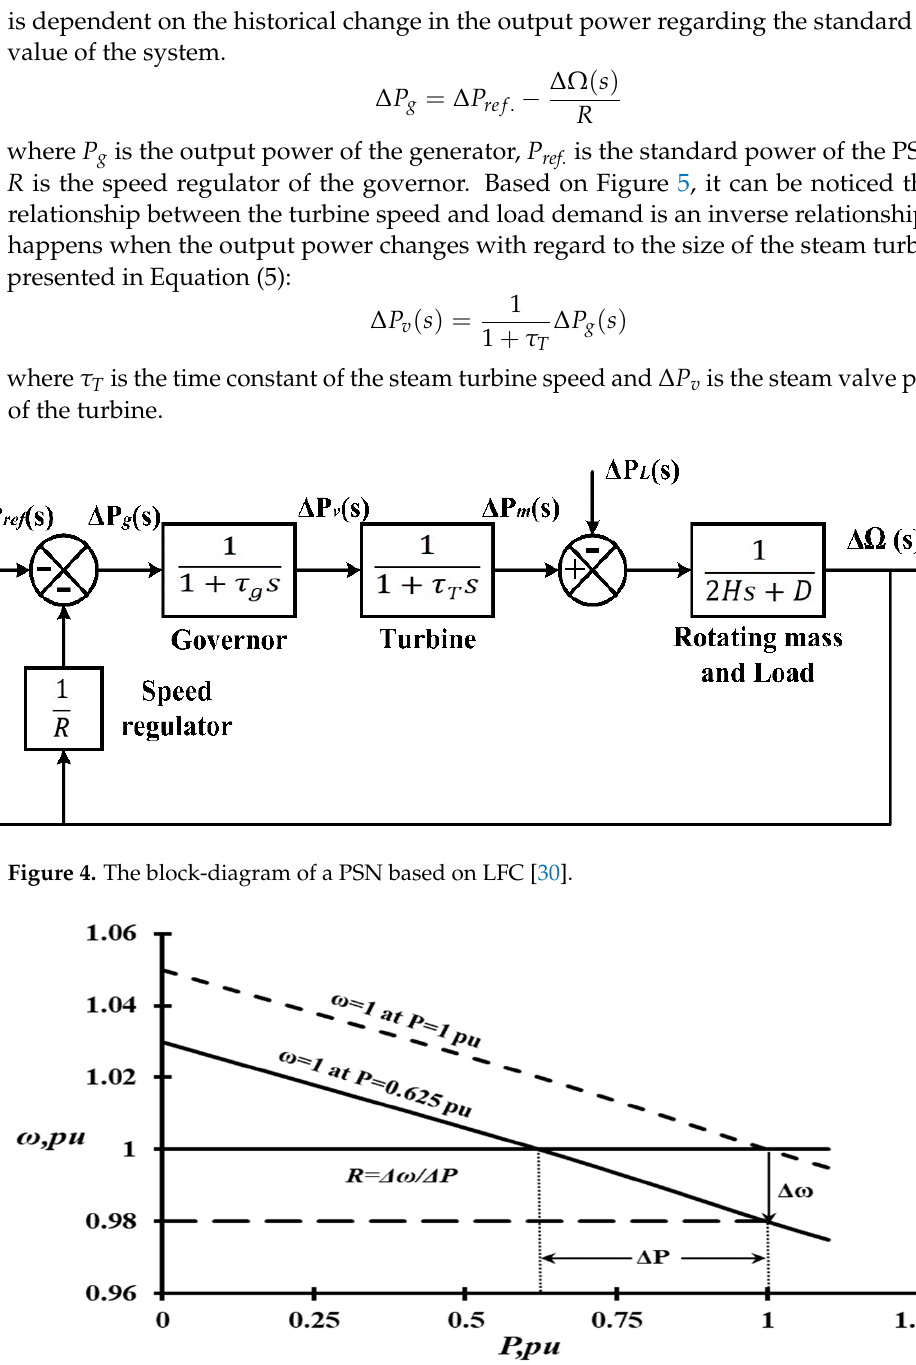
Figure 5. The state space characteristics of a governor.